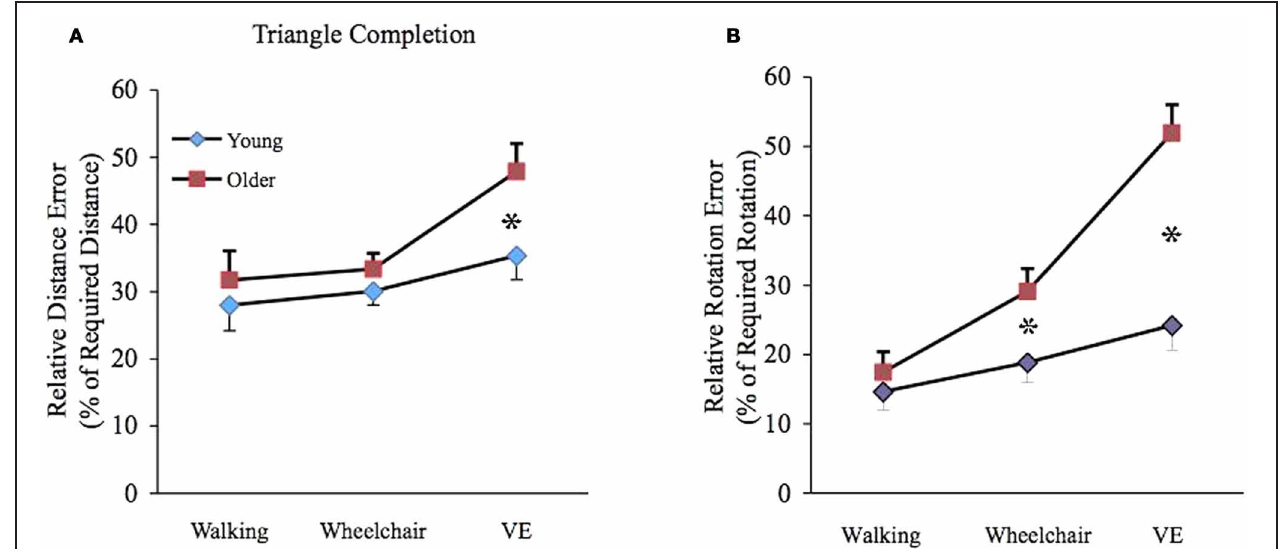
FIGURE 2 | (A) Mean ( ± SE) relative distance error (RDE) for young (filled diamond) and older (filled square) participants. Age differences were significant in the VE condition ( ∗ p < 0 . 05). (B) Mean ( ± SE) relative rotation